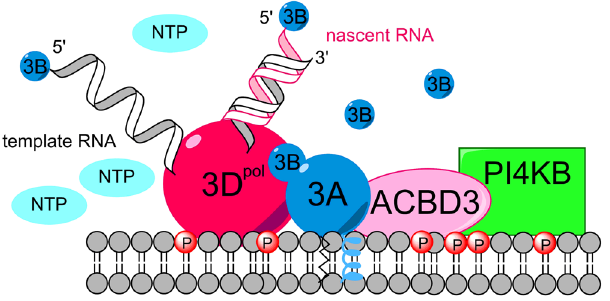
Figure 5. Schematic model of the 3D pol :3AB:ACBD3:PI4KB protein